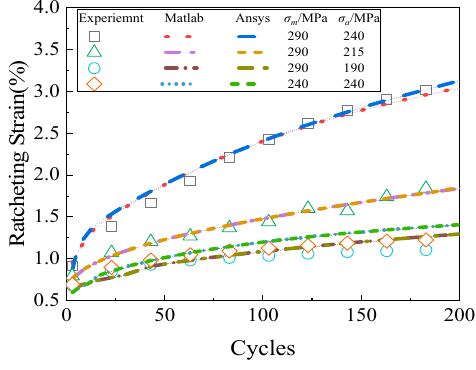
Figure 19. The simulation results of uniaxial ratcheting for the specimen.